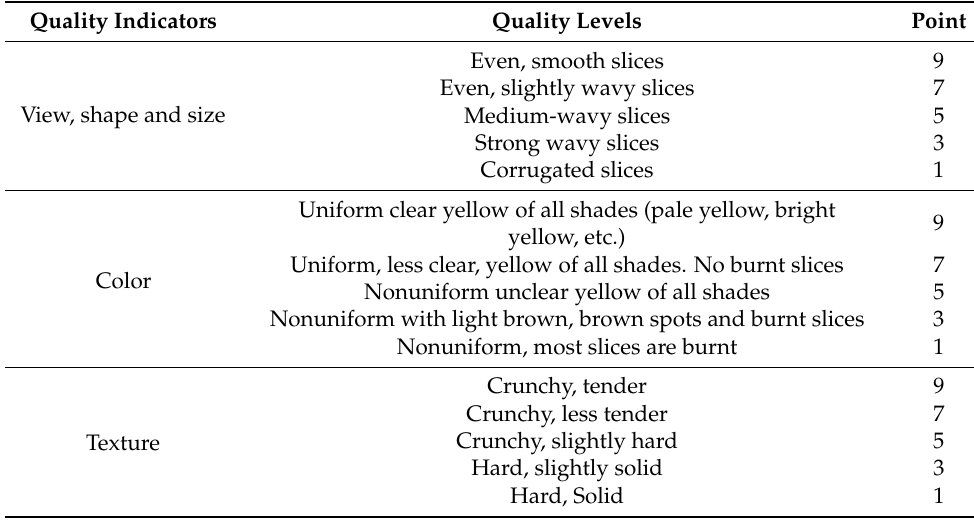
Table 2. Evaluation of potato chips quality in